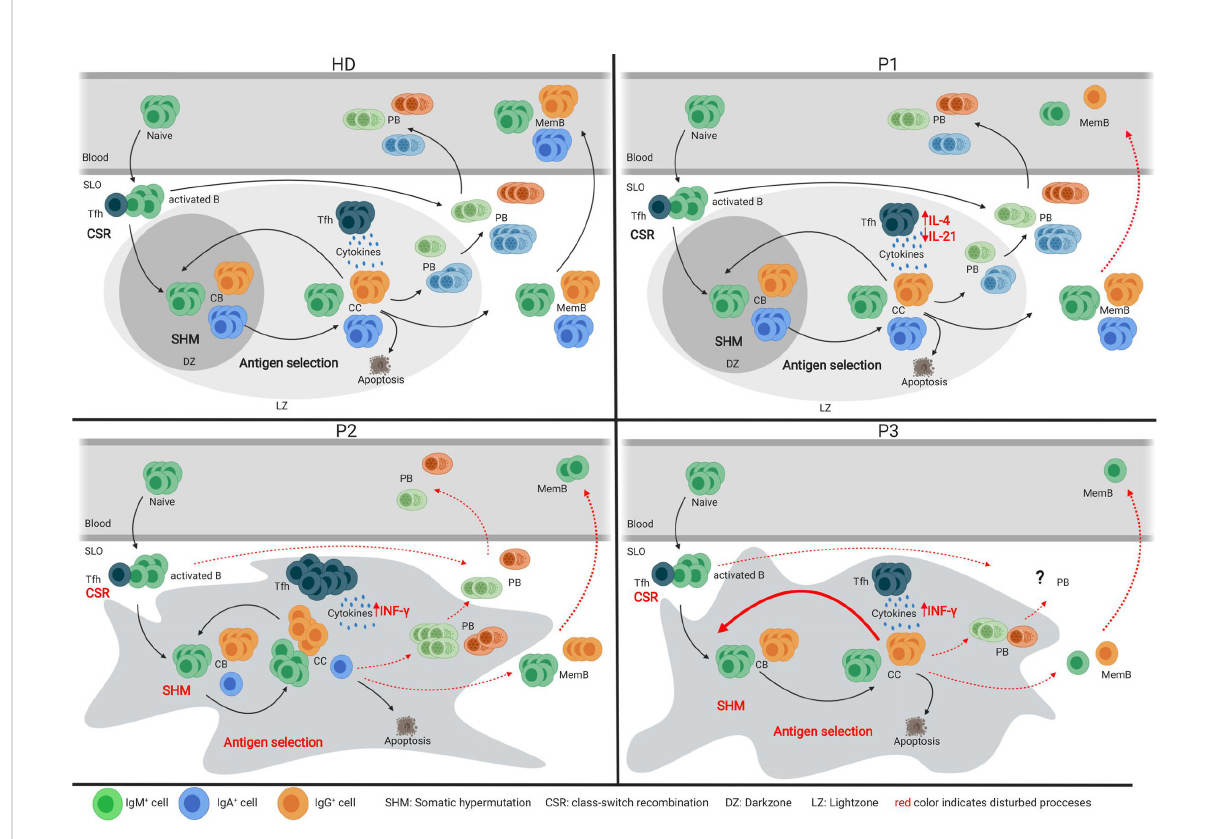
FIGURE 6 Models of the germinal center of HDs and three CVID patients. Models depicting the germinal center response in HDs and three individual CVID patients. Red font indicates impaired processes in the patient ’ s GC